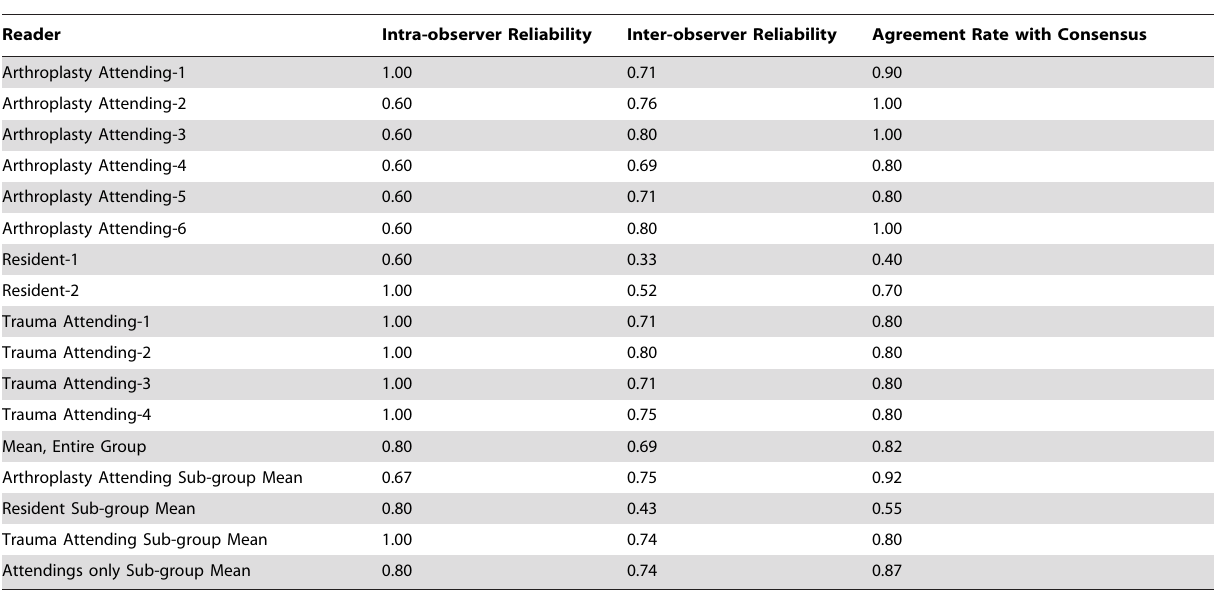
Table 2. Performance by reader assessing displacement.